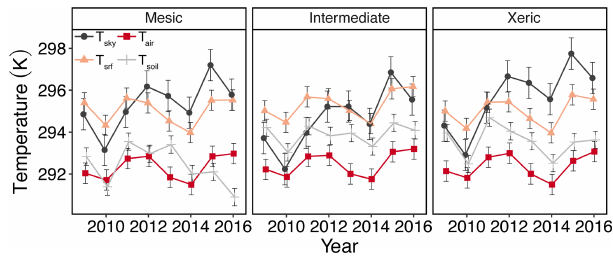
Figure 2. Least squares mean predicted values from mixed mod- els of annual sky temperature ( T sky ), air temperature ( T air ), surface temperature ( T srf ), and soil temperature ( T soil ) at the mesic, inter- mediate and xeric sites. Error bars represent